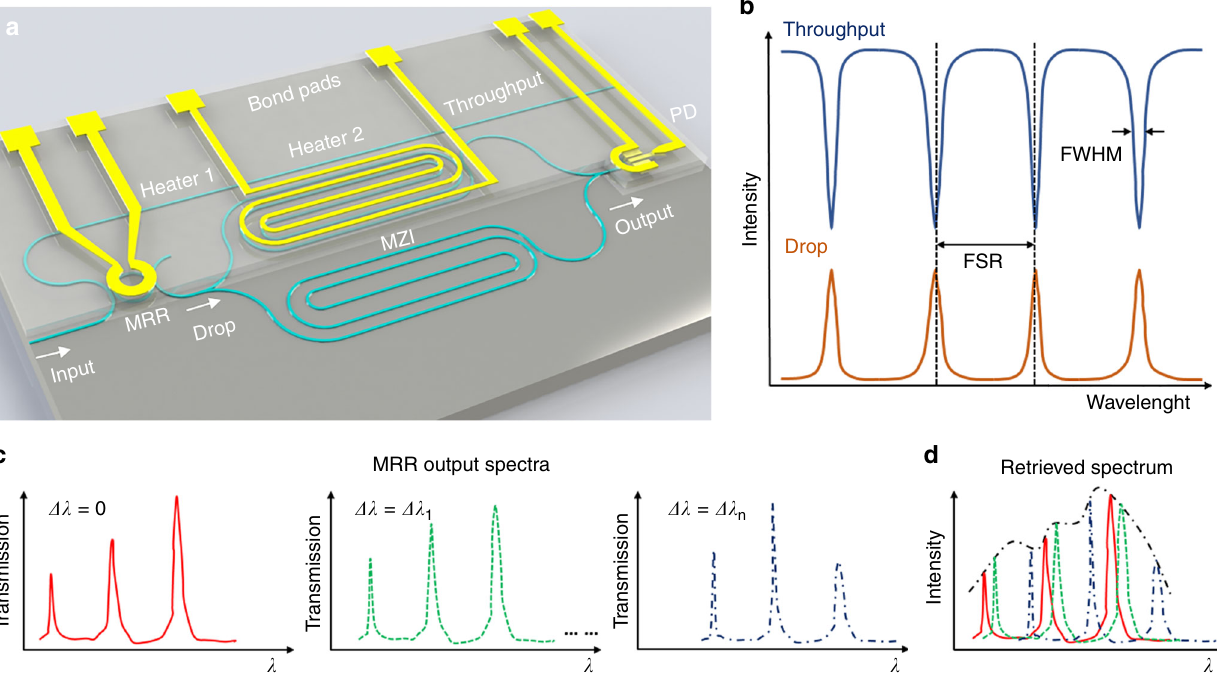
Fig. 1 Microring resonator-assisted Fourier-transform spectrometer. a Schematic of the RAFT spectrometer consisting of an MRR and an MZI both with heaters on top integrated with a PD. b Schematic transmission spectra of the MRR. Free spectral range (FSR) is the separation between adjacent dips (peaks) and full width half maximum (FWHM) denotes the linewidth of the dips (peaks). c Schematic of output fi ltered spectra from the drop port of the MRR at three tuning states (0 < Δ λ 1 < …… < Δ λ n < FSR), which are denoted by lines with different styles (colors). d Schematic retrieved spectra at different tuning states (denoted by lines with different styles (colors)) by the tunable MZI. The original input spectrum (denoted by black dotted line) can be retrieved by combining all the retrieved